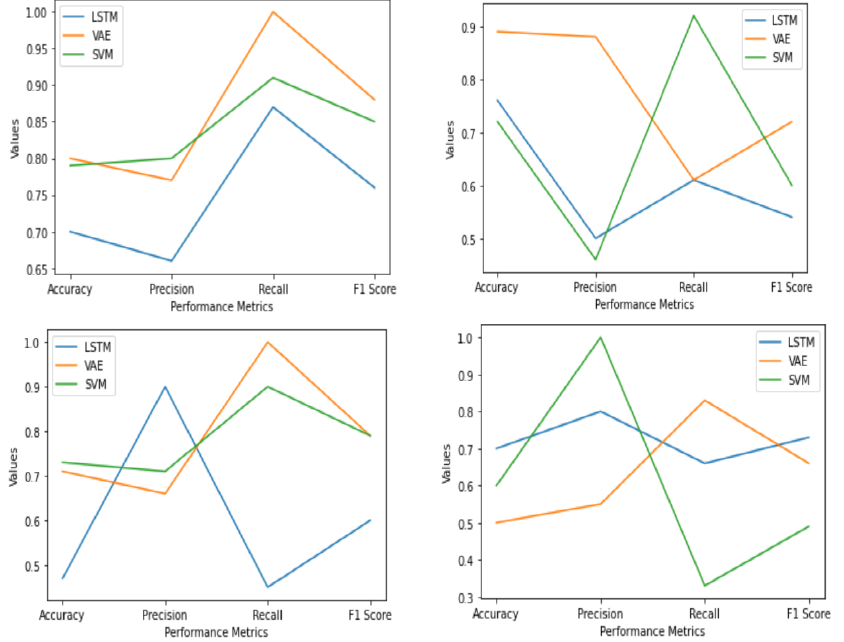
Figure 15. Graph plotted for validation phase of 2D image and color doppler and testing phase of 2D image and color doppler respectively, without k fold cross validation.